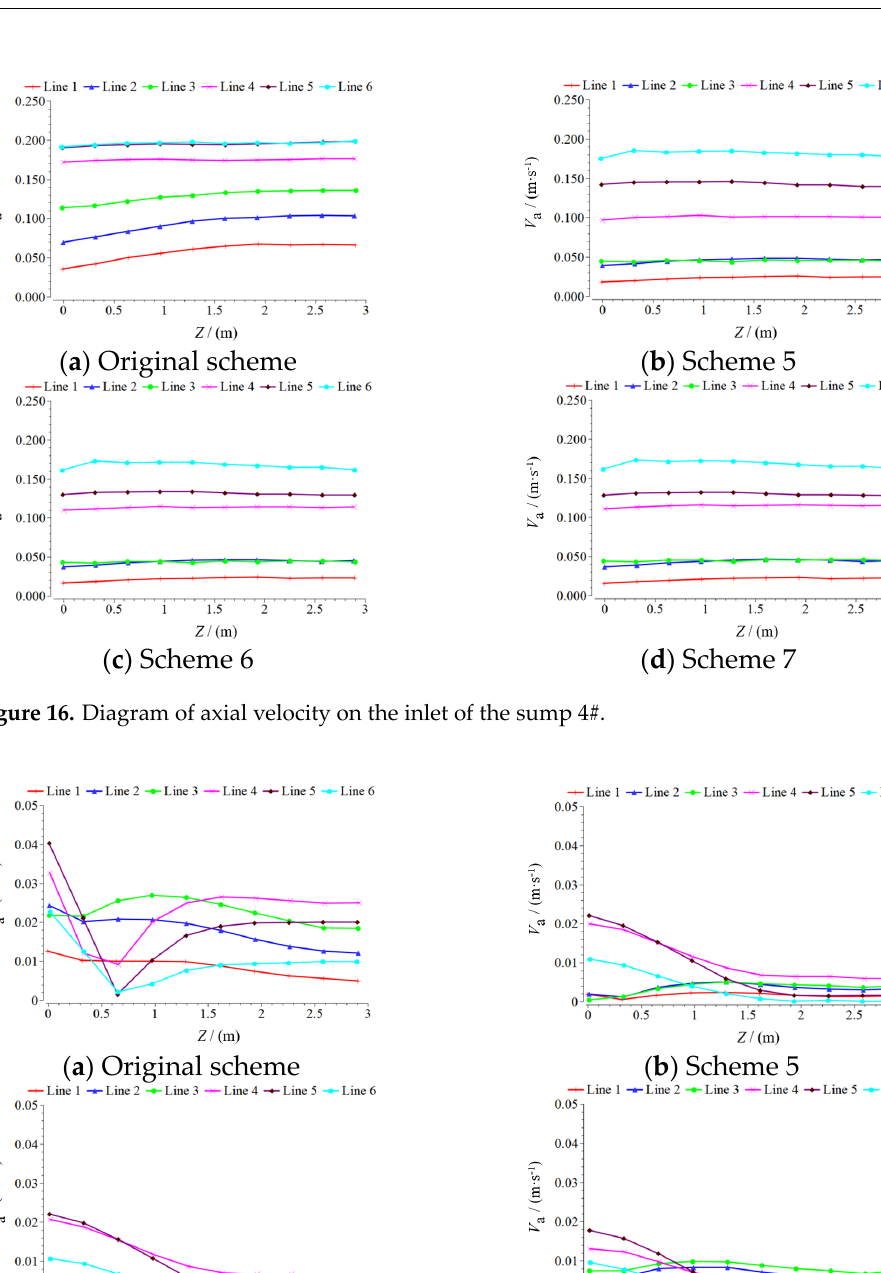
( d ) Scheme 7 Figure 14. Diagram of axial velocity on the inlet of the sump 2#. ( a ) Original scheme